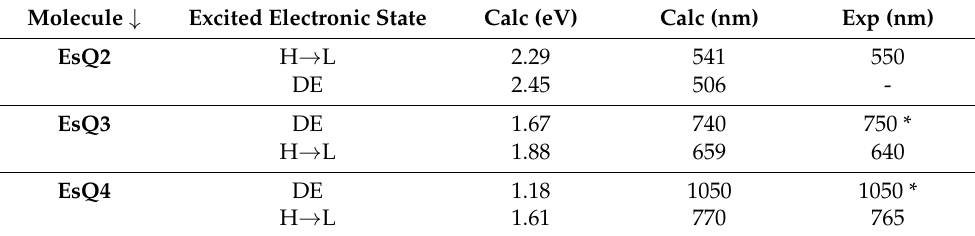
* onset of the absorption